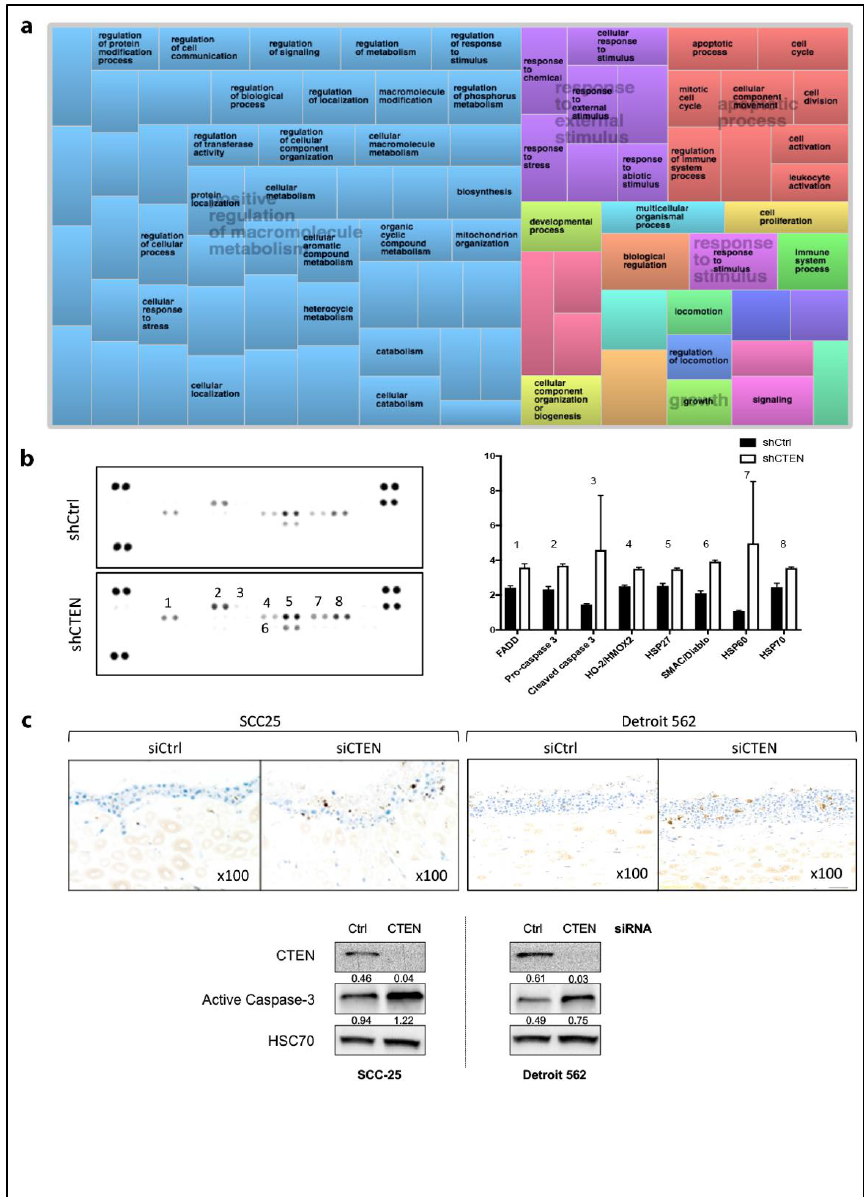
Figure 4. CTEN expression promotes apoptotic pathways. ( a ) TreeMap visualisation obtained from REVIGO [44] analysis of the summary of gene ontology terms for all di ff erentially expressed genes ( p < 0.01) between control and CTEN siRNA-treated samples, with ‘Apoptotic Process’ domain figuring prominently (top right). Related ontology terms with semantic similarity are grouped in the same colours and the dimensions of the coloured areas are proportional to the direction of the